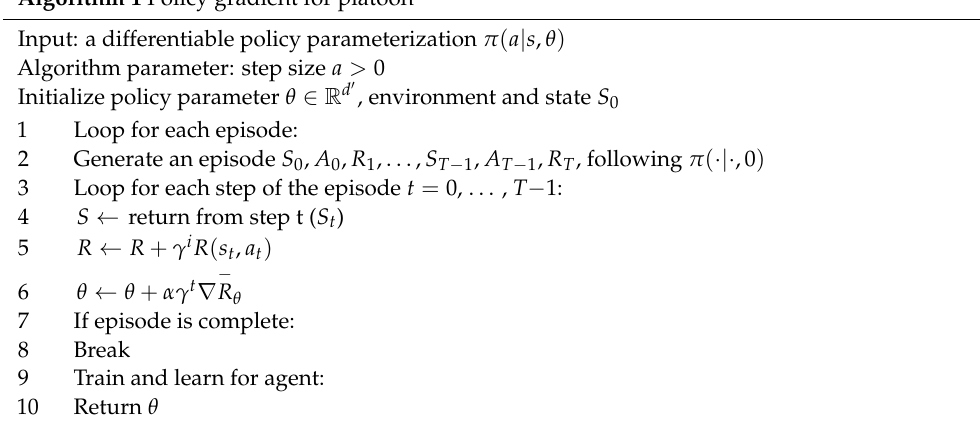
Algorithm 1 Policy gradient for